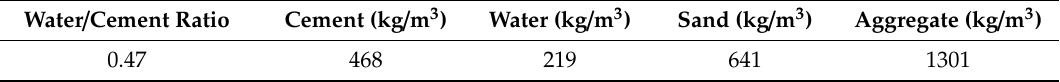
Table 2. Concrete mix proportions.